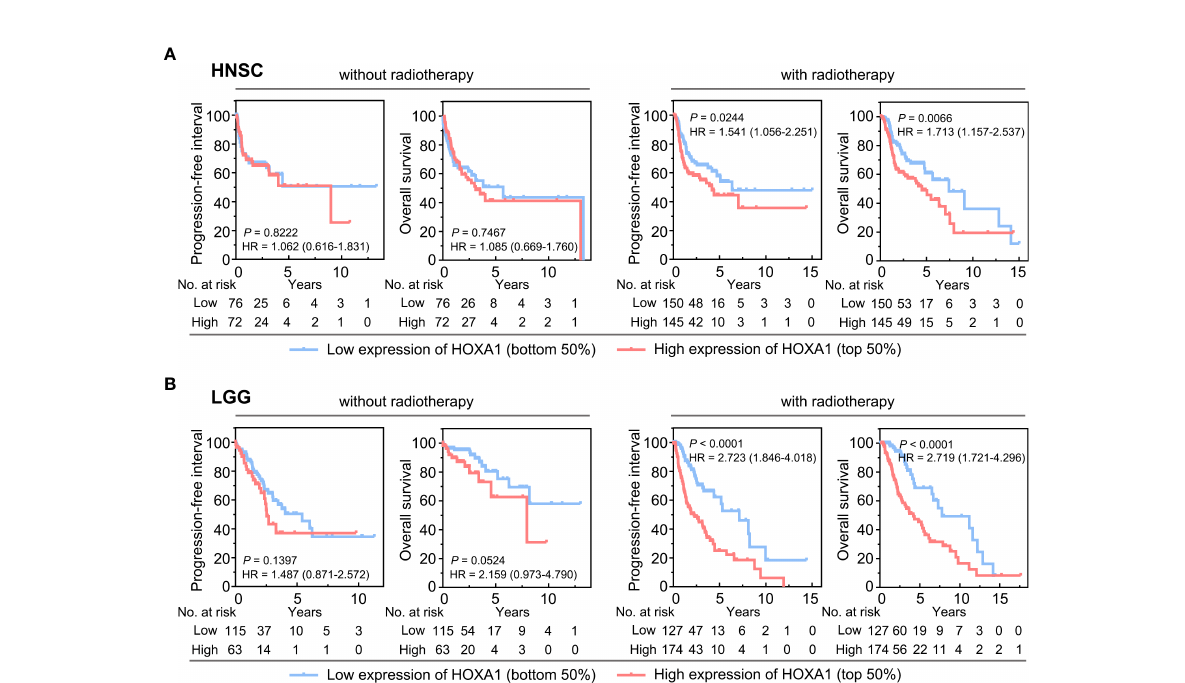
FIGURE 2 HOXA1 expression had prognostic signi fi cance in HNSCC and LGG patients receiving postoperative radiotherapy. (A) Overall survival (OS) and progression-free interval (PFI) curves of HNSCC patients with and without postoperative radiotherapy. (B) OS and PFI curves of LGG patients with and without postoperative